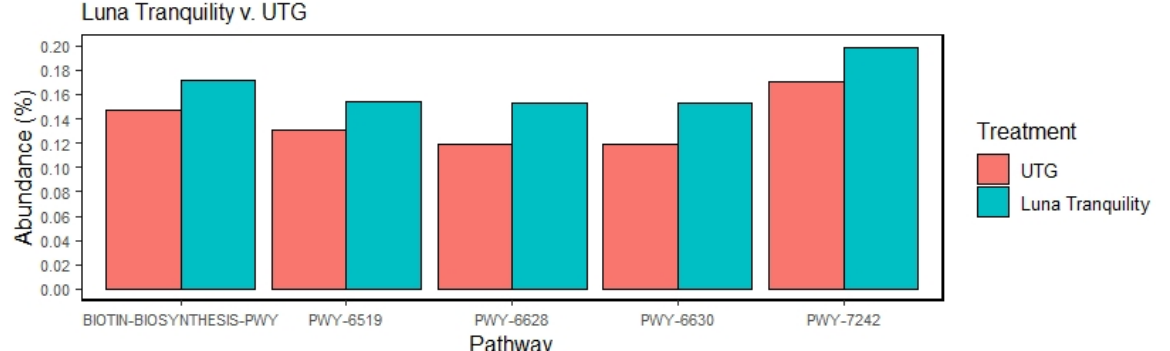
Figure 4. Functional pathways which differed significantly between Luna Tranquility and UTG.